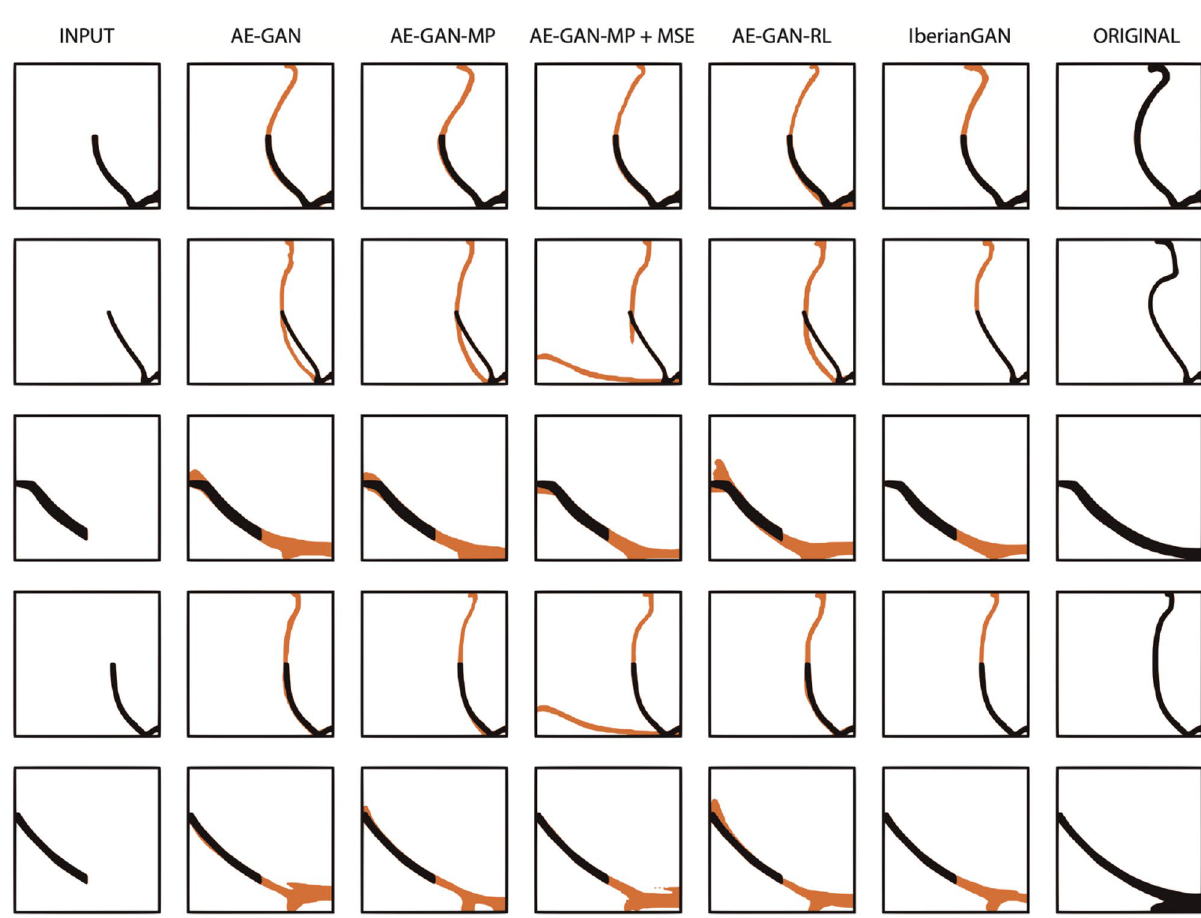
Figure 4. Random examples were sampled to compare the performance of IberianGAN against the other approaches. The generated pottery is in orange. In black is the input